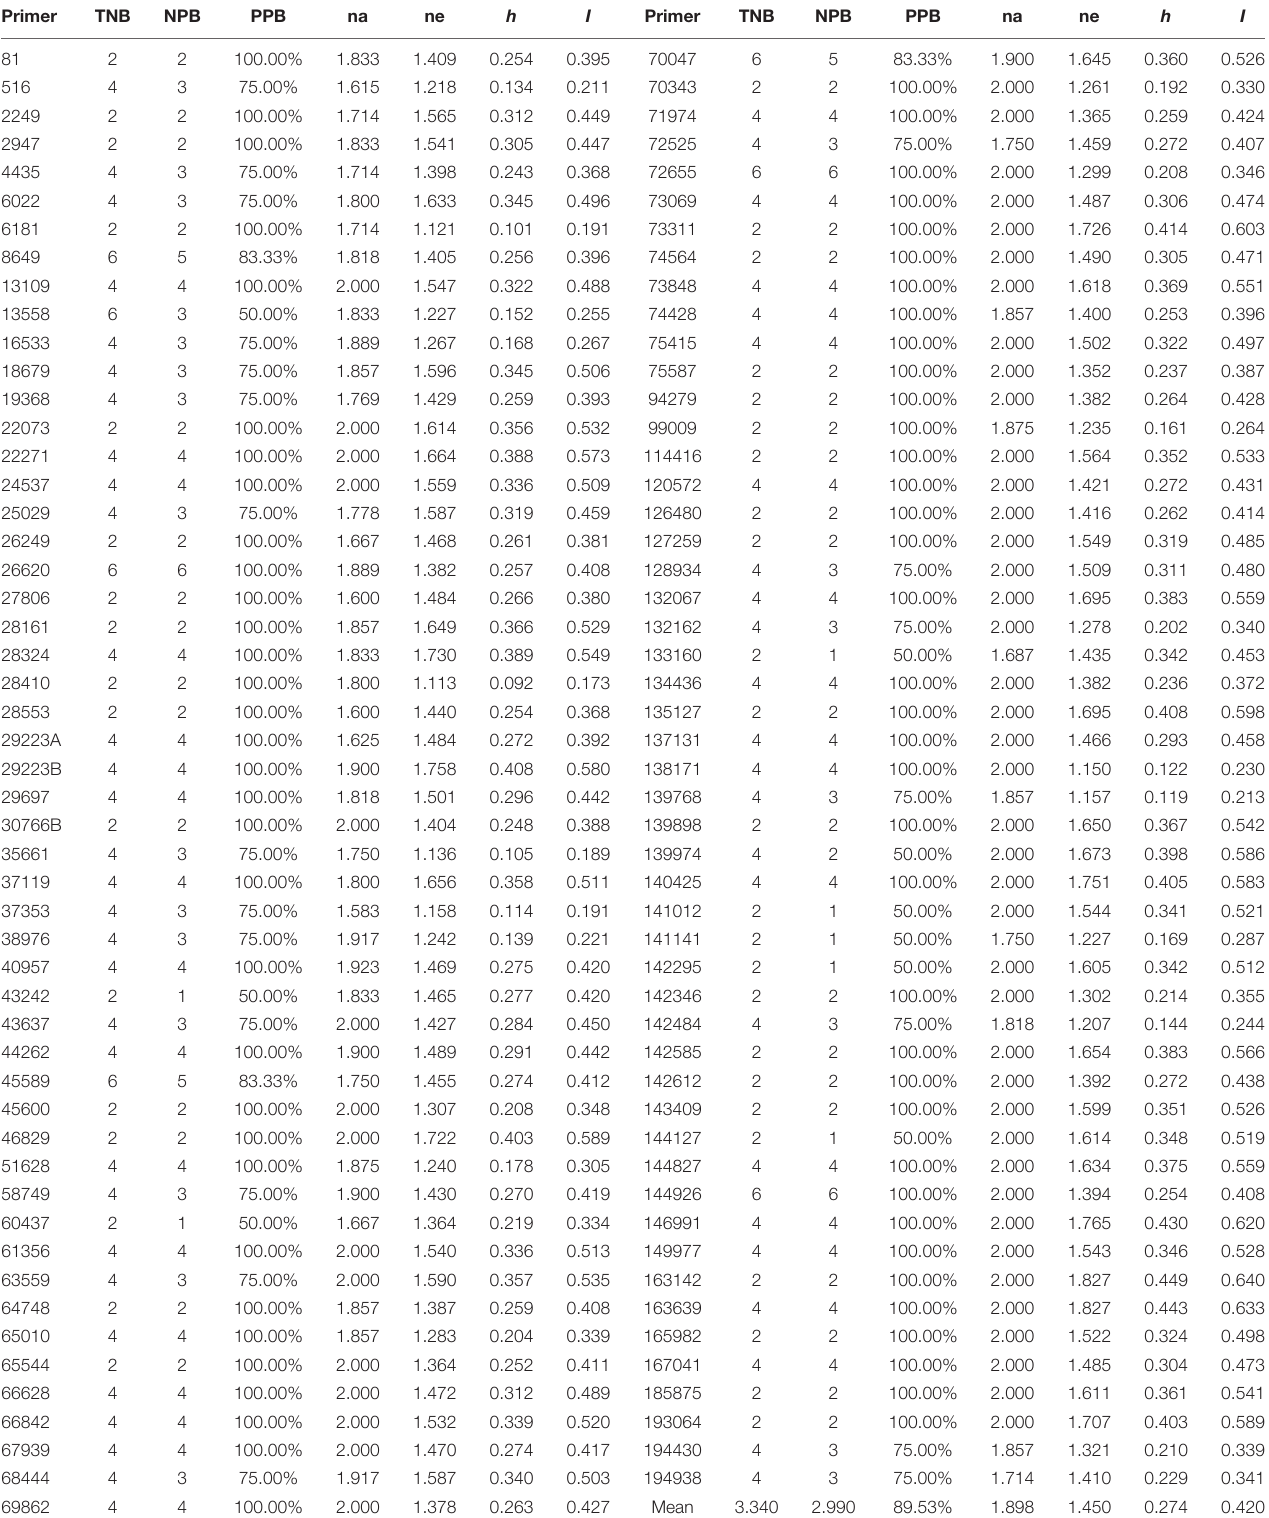
TABLE 4 | Polymorphism analysis of 103 EST-SSR primers of Psathyrostachys juncea